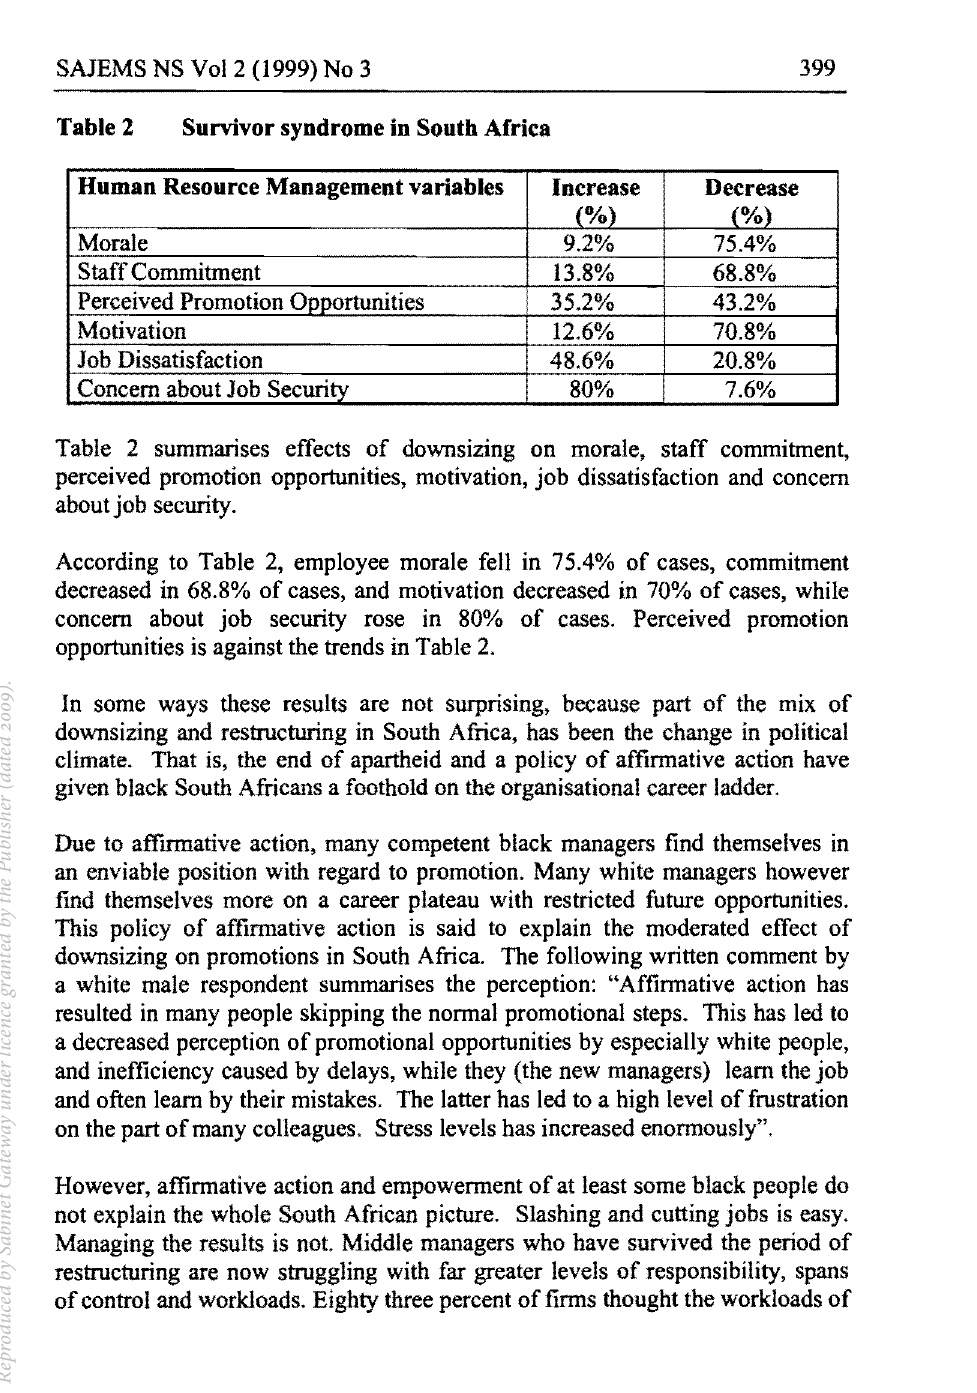
Table 2 Survivor syndrome in South Africa